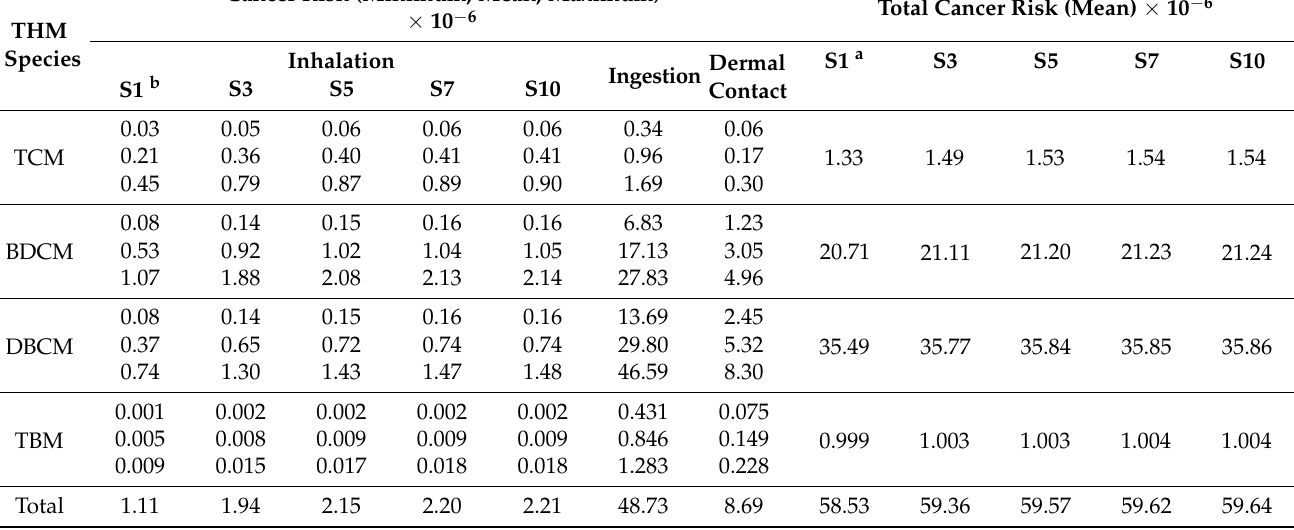
Table 3. 10th, 50th, and 90th percentile values and total cancer risk per THM compound for successive showering events in common showering